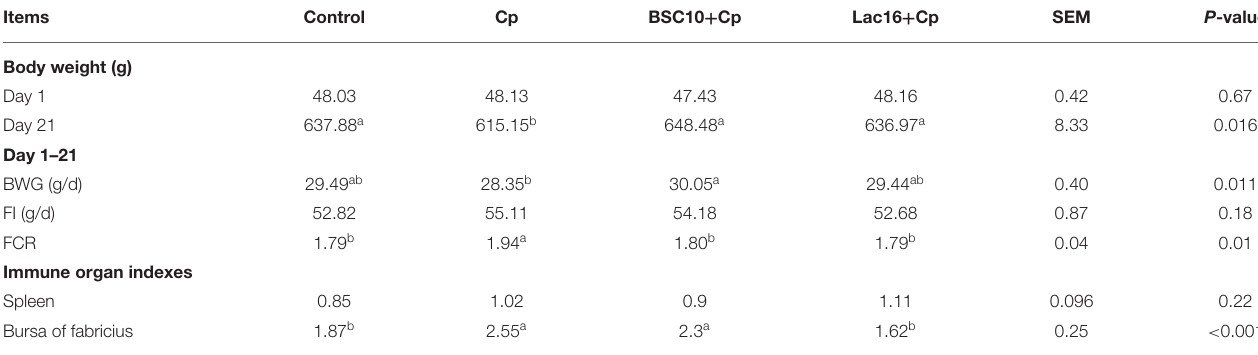
TABLE 1 | Effect of probiotics on growth performance and immune organ indexes of broilers infected with C. perfringens . Items